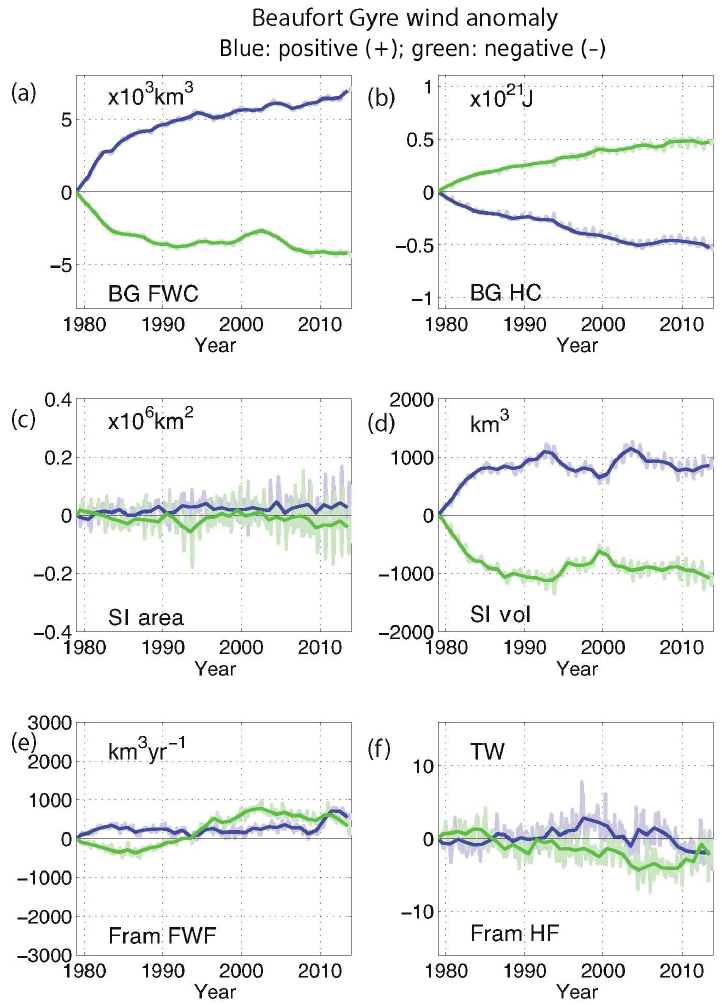
Figure 6. CRFs for the Beaufort Gyre wind anomaly, blue ( + ) and green ( − ) . Note that the + sign implies a stronger anti-cyclonic forcing. The response to a 4hPa surface pressure anomaly (see Fig. 5a) is shown of (a) C W BG , the FWC of the BG (b) C W BG , HC of the BG (c) FWC BG HC BG C W BG , SI area (d) C W BG , SI volume (e) C W BG , FWF through the Fram Strait and (f) C W BG , the HF through the Fram Strait. Note that FWF Fram HF Fram SIA SIV the units of the y axis appear in the top-left-hand corner of each